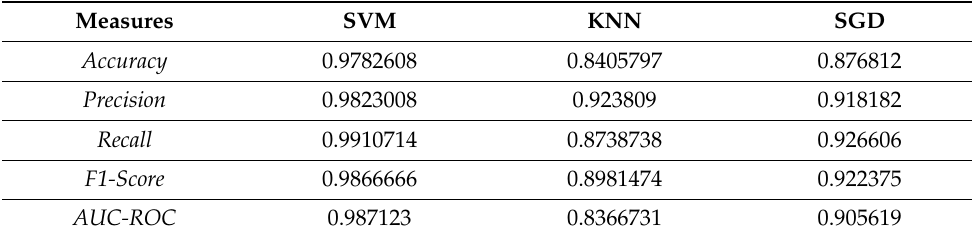
Table 8. Results of Train–Test–Split Evaluation.